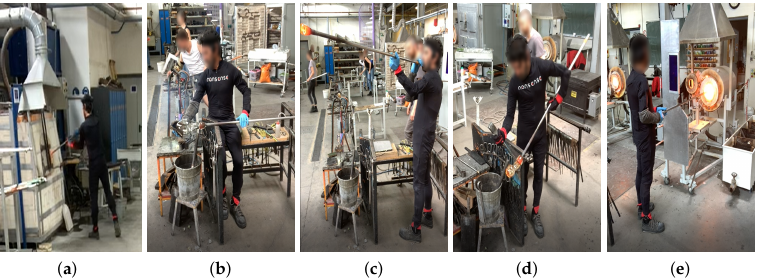
Figure 4. Gesture vocabulary with gestures for glassblowing (G 3 ). ( a ) G 3,1 : Grab glass melt from the oven; ( b ) G 3,2 : Shape the carafe’s curves; ( c ) G 3,3 : Blow through the blowpipe; ( d ) G 3,4 : Shape the carafe’s neck with pliers; ( e ) G 3,5 : Heat the glass of the